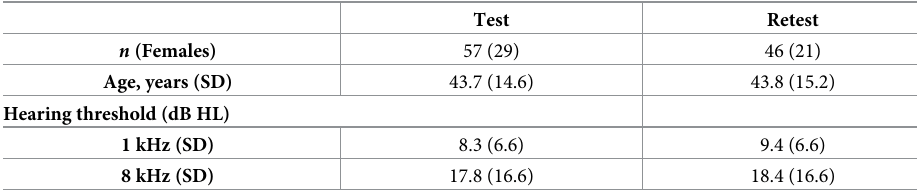
Table 1. Subject